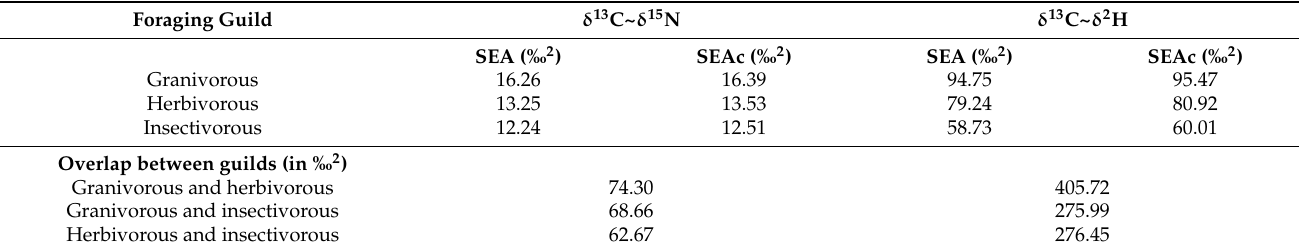
Table 4. Standard ellipse areas (SEA) and ellipse areas corrected for small sample size (SEA c ), and pairwise isotopic niche overlap between these foraging